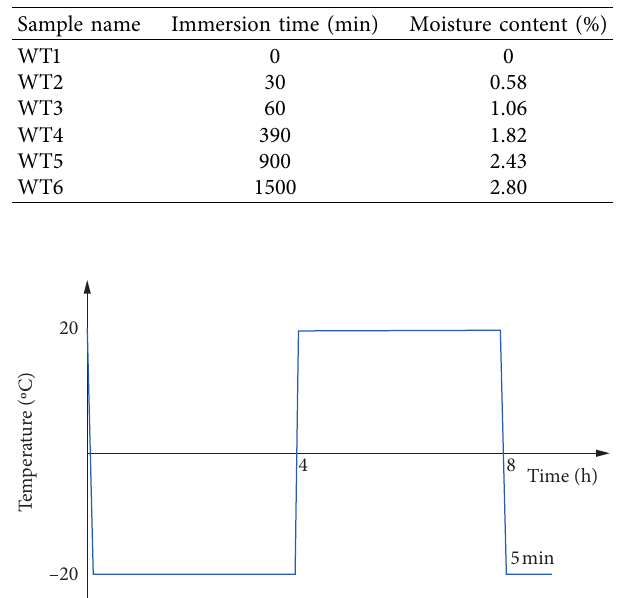
Table 2: The moisture content of sandstone samples.